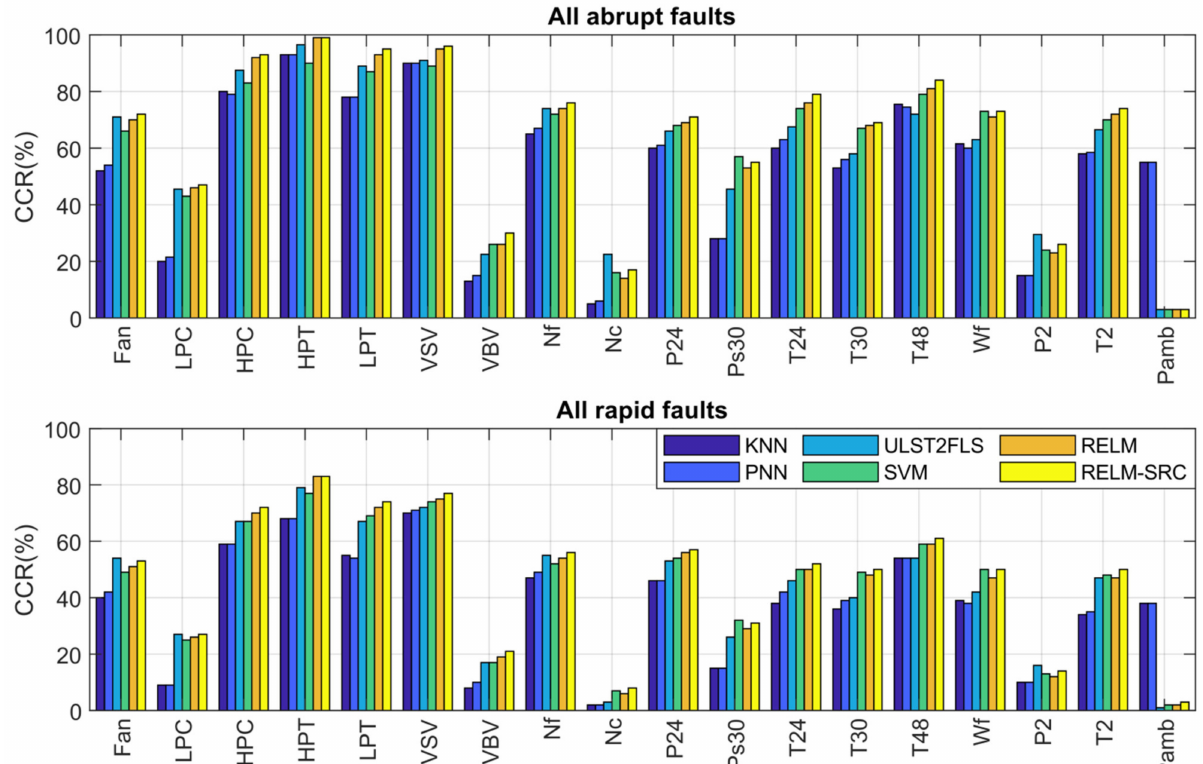
Figure 8. Correct classification rates for abrupt and rapid faults (Stage